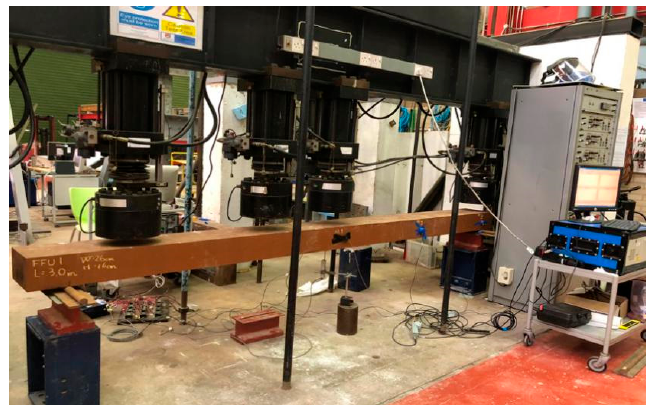
Figure 2. Testing arrangement of a full-scale test.